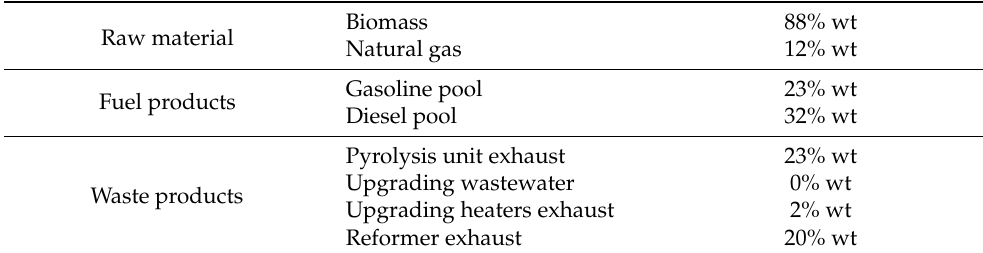
Table 3. Carbon balance of product fuel from wood [74].